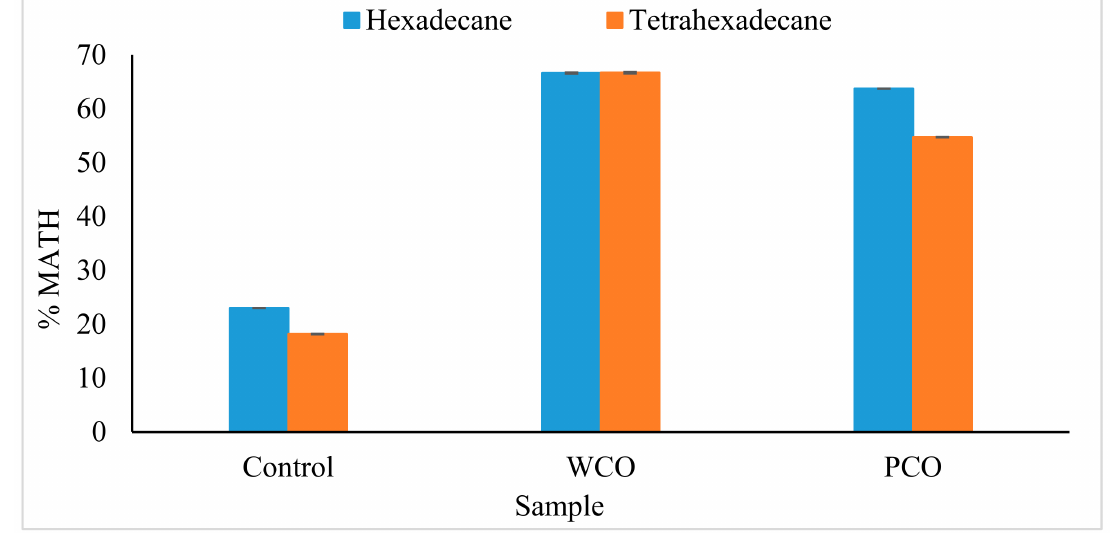
Figure 5. Microbial adhesion of BS14 bacterial consortium to two different hydrocarbon substrates. Error bars represent mean ± standard error (SEM).